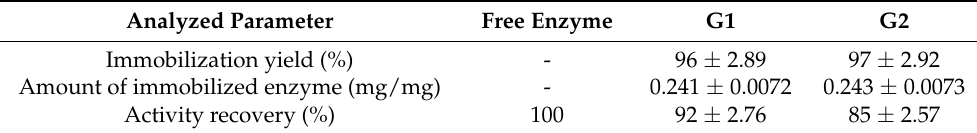
Table 3. Characteristics of the enzyme before and after immobilization. The conditions of reaction were as follows: 30 ◦ C, pH = 7, time duration 24 h, volume of a process 5 mL, 100 mg of support, and a 5 mg/mL concentration of lipase. All data are presented as the means ± standard deviation of three experiments. Analyzed Parameter Free Enzyme G1 G2 Immobilization yield (%) - 96 ± 2.89 97 ± 2.92 Amount of immobilized enzyme (mg/mg) - 0.241 ± 0.0072 0.243 ± 0.0073 Activity recovery (%) 100 92 ± 2.76 85 ±